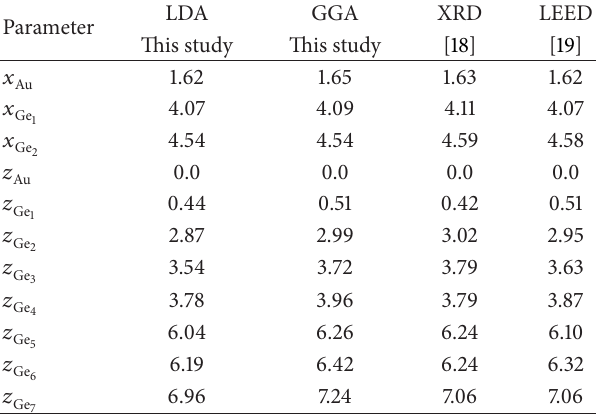
Table 1: Atomic positions (in ˚A), as defined in Figure 2, obtained in this study within the LDA and GGA theories and reported in the surface-X-ray-diffraction (XRD, [18]) and low-energy electron- diffraction (LEED, [19])